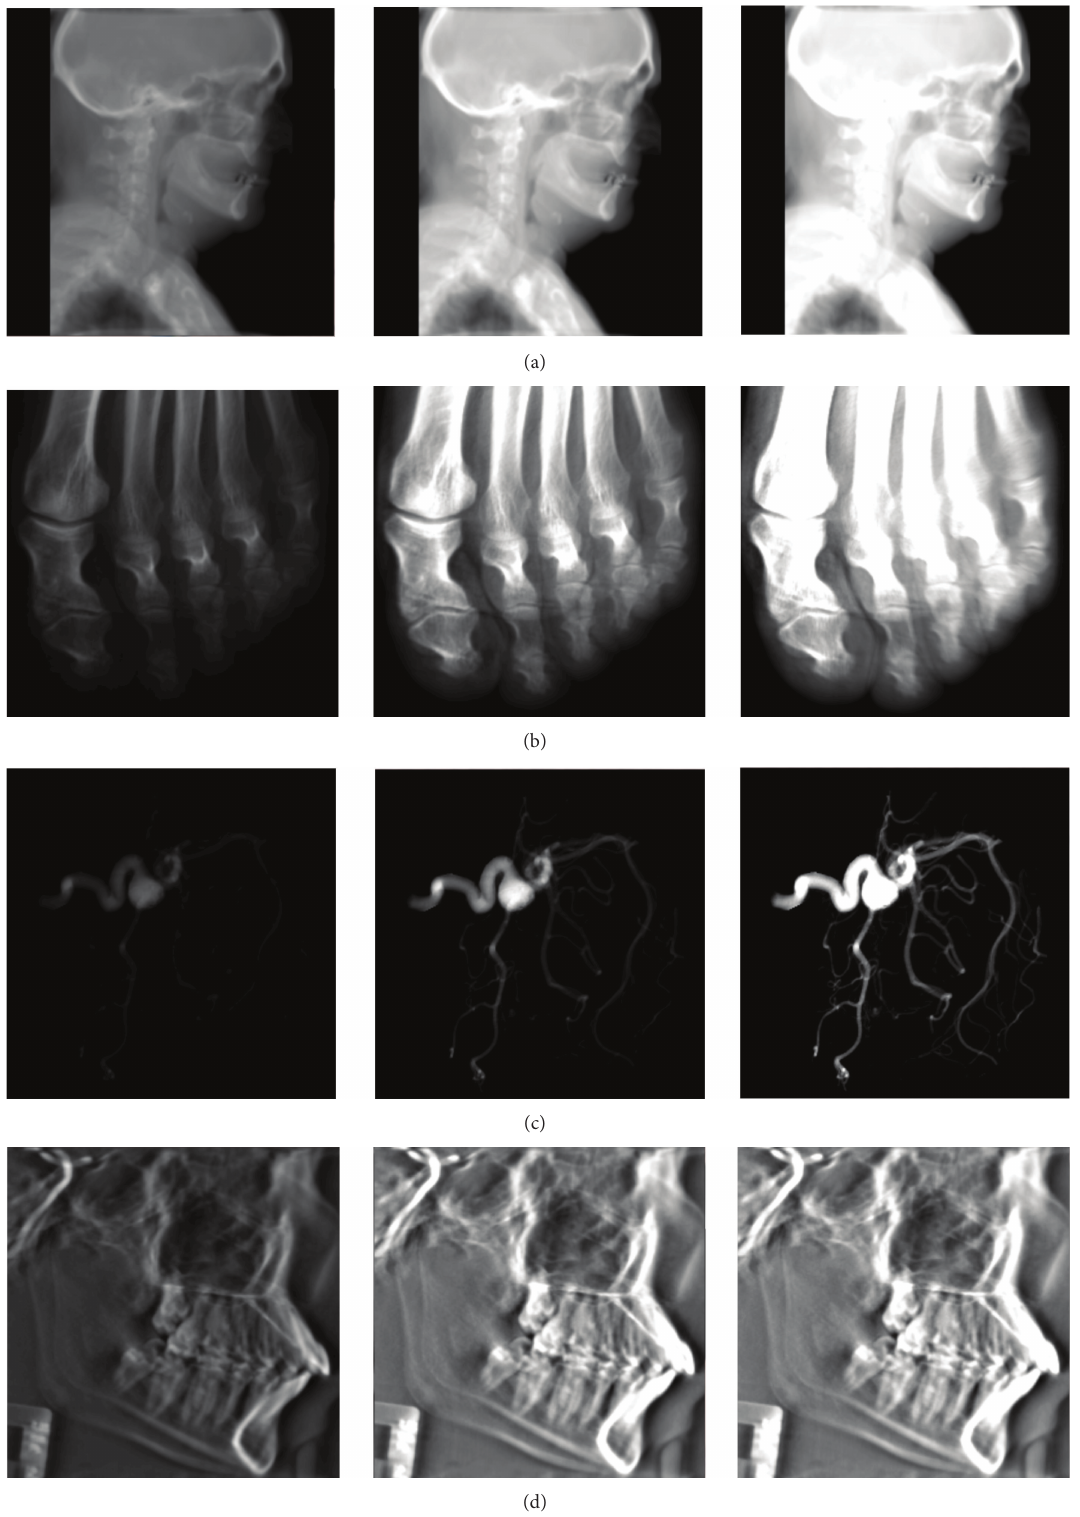
Figure 8: Reconstruction results of rendering several datasets with different projection-slice resolutions and multiple intensity scaling factors. In (a), a sagittal projection of the visible male dataset. In (b), an axial projection of a foot dataset. In (c), a front view of an aneurysm dataset. In (d), a sagittal projection of a skull